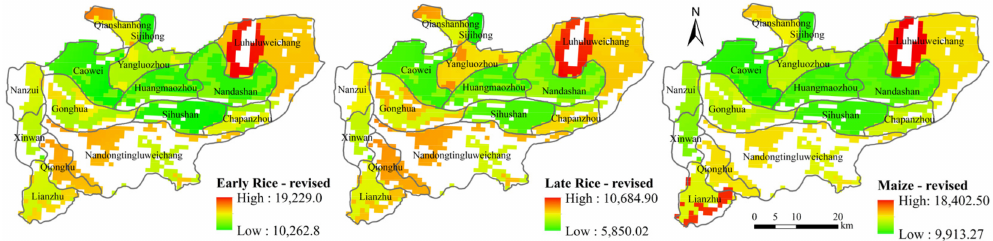
Figure 7. Farmland production potential of the main grain crops in Yuanjiang